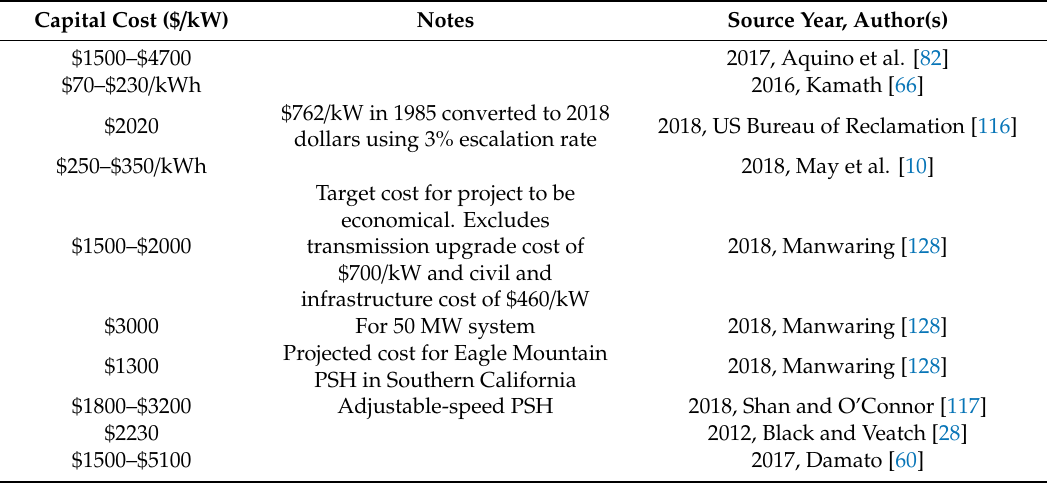
Table 23. Capital cost estimates—PSH